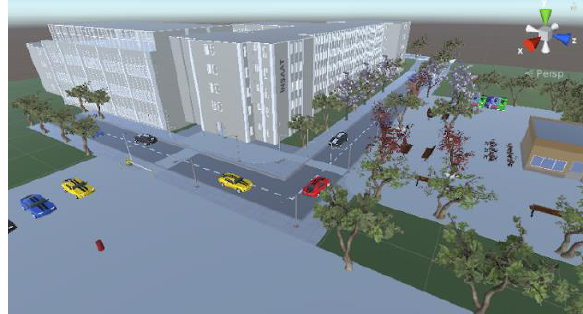
Figure 2. Visualization of Faculty building